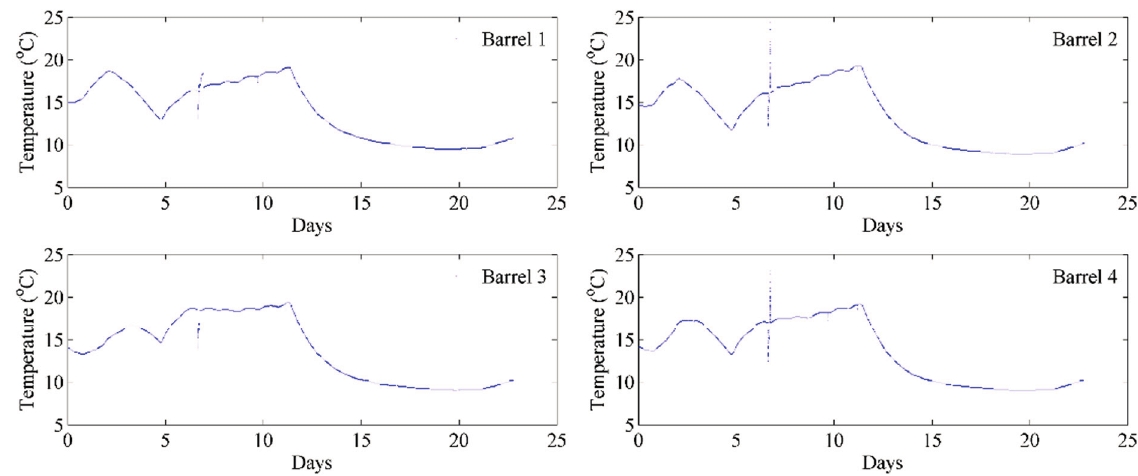
Figure 7. Continual monitoring of temperature of four barrels of wine during fermentation.